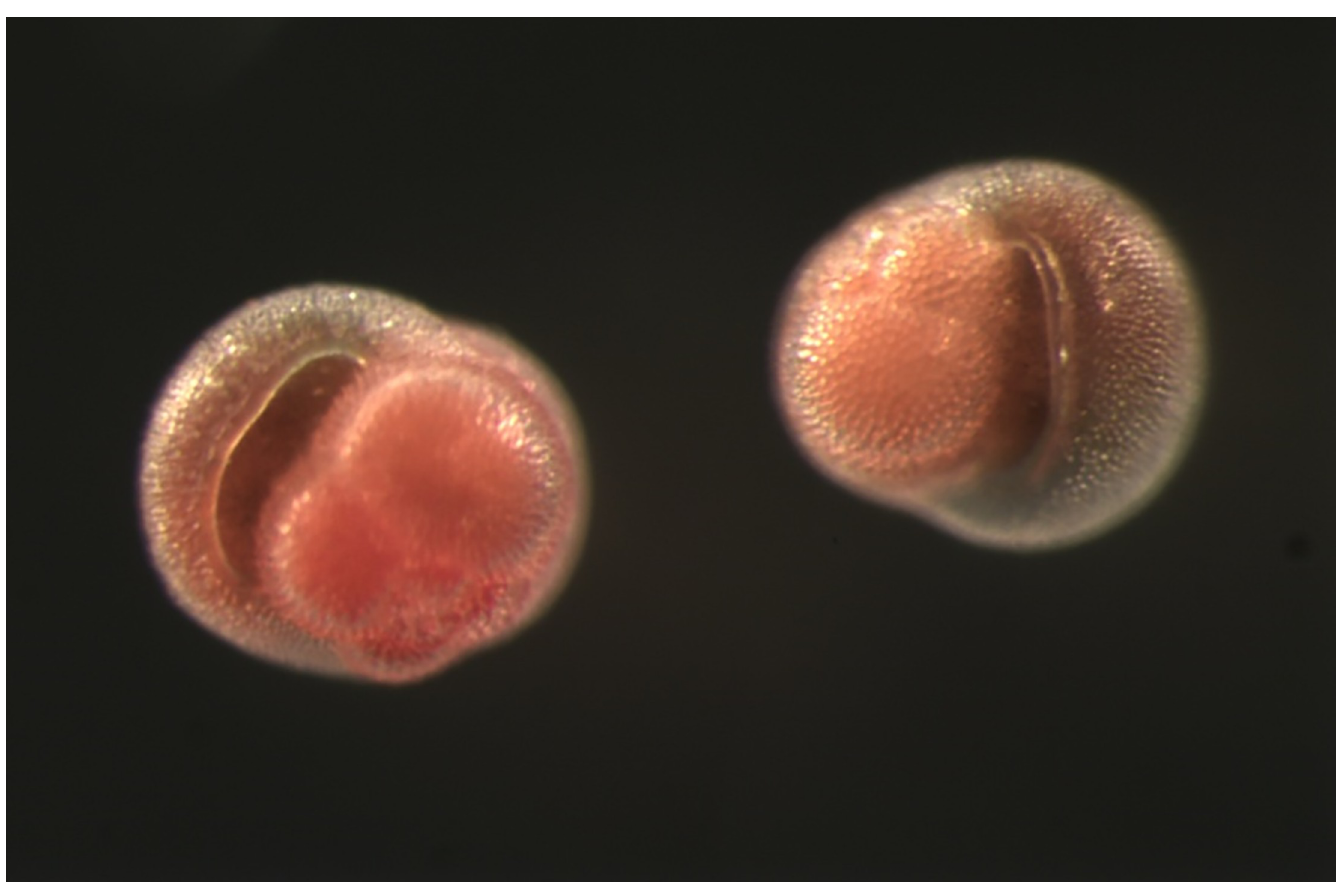
Fig 1. Live Pulleniatina obliquiloculata from the Sargasso Sea. Width of specimens approximately 400 μ m (credit: Colomban